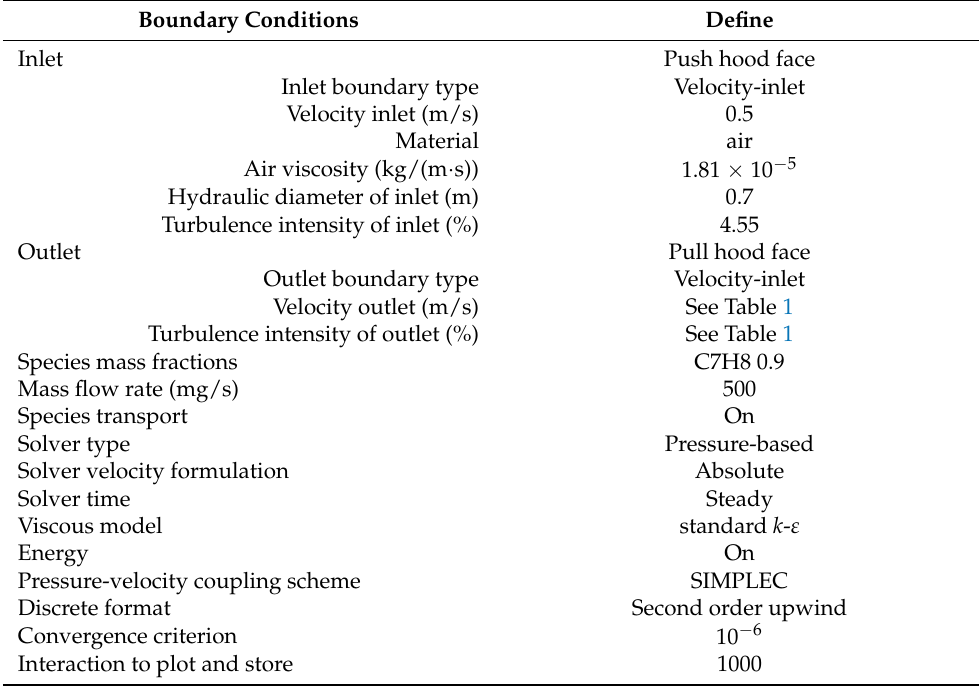
Table 2. Boundary conditions and solver